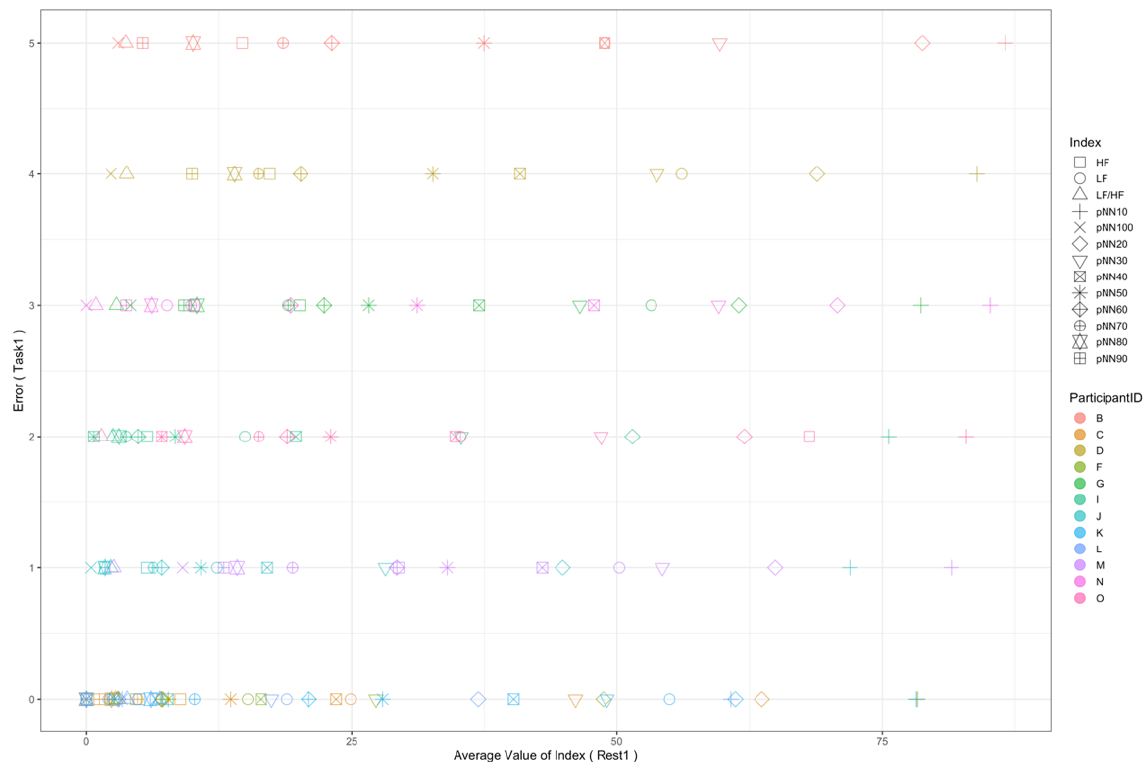
Figure 7. Scatterplot between the number of errors of Task1 vs. the HRV indexes during Rest1.